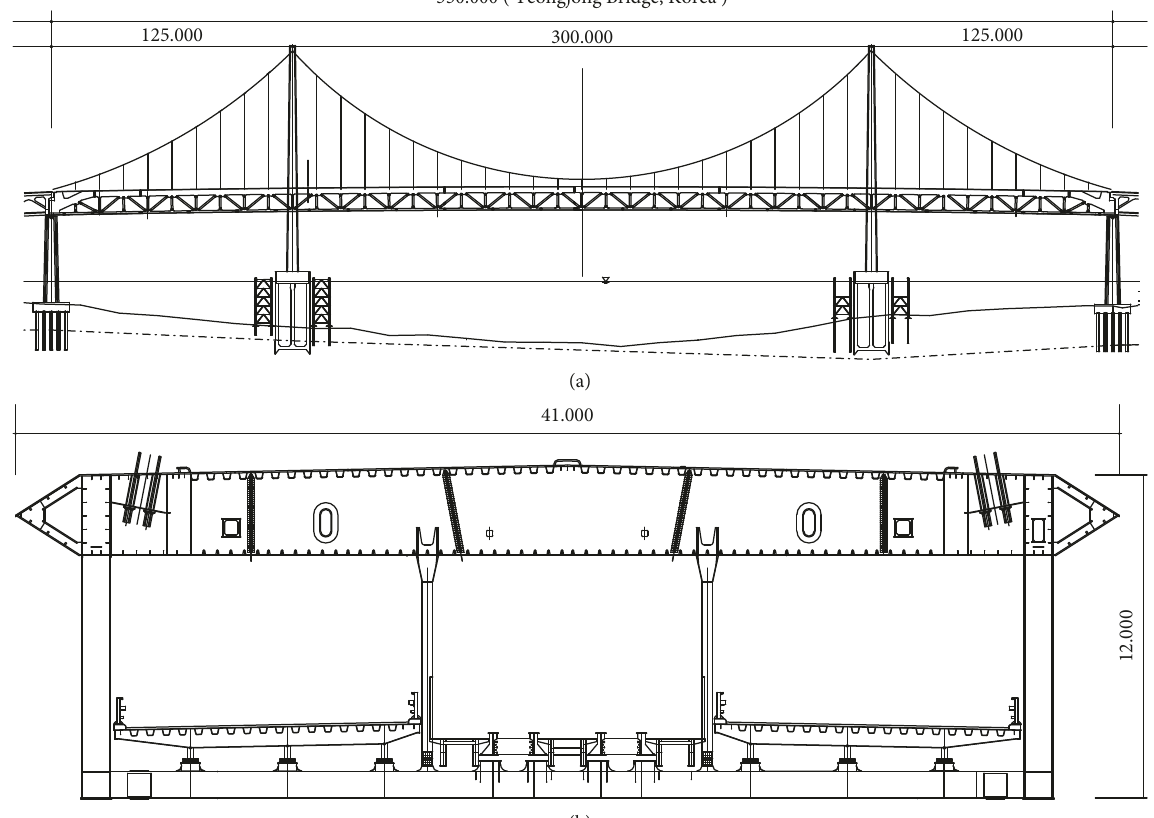
Figure 1: Yeongjong Bridge, in Korea. (a) Side of the bridge. (b) Cross section of the bridge.